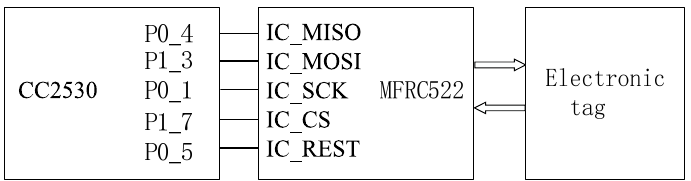
Figure 5. The I/O port circuit between CC2530 and MF RC522.